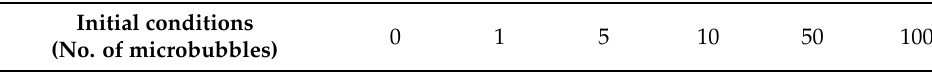
Figure 2. Schematic of Gillespie’s algorithm. Table 1. Initial conditions and supply of bubbles.